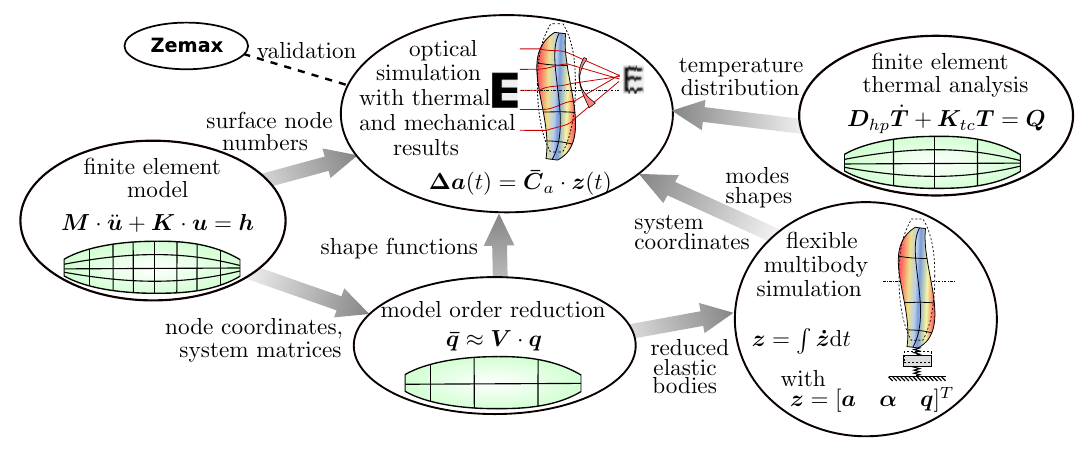
Figure 2. Workflow of the described dynamical-optical system simulation.